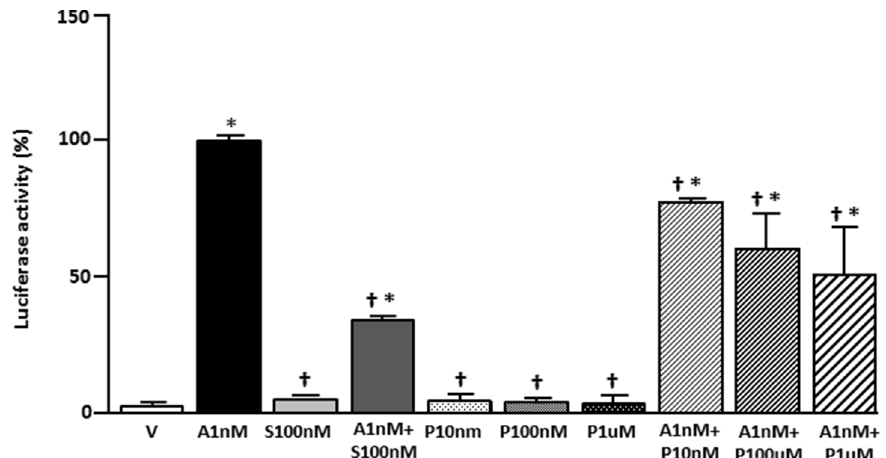
Figure 5. Effect of PASE on aldosterone-induced human mineralocorticoid receptor (hMR) transcriptional activity. CV-1 cells transfected with hMR expression and MMTV-LUC reporter plasmids were treated with vehicle (V) or aldosterone 1 nM (A1 nM) in presence of spironolactone 100 nM (S100 nM) or PASE 10 nM, 100 nM or 1 m M (P10 nM, P100 nM or P1 m M). Each data point represents the mean 6 SEM derived from 3 independent experiments. *p , 0.01 vs V; { p , 0.05 vs. A1 nM.